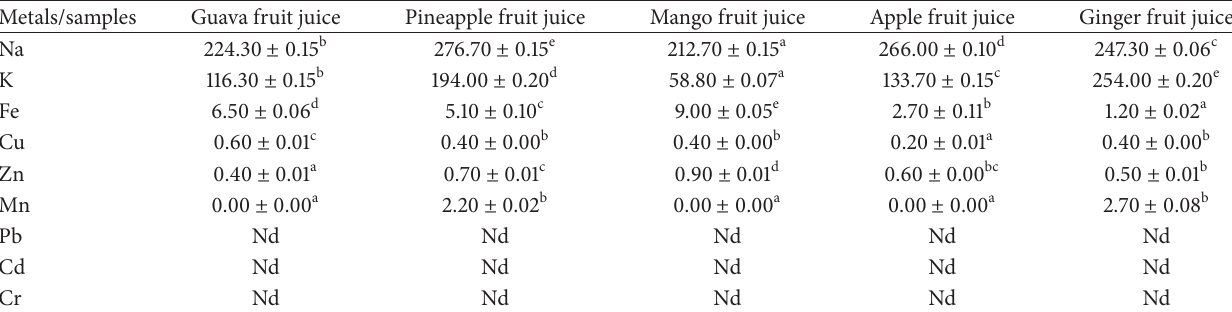
Table 1: Trace metal and mineral content in different canned fruit juices (mg/L).